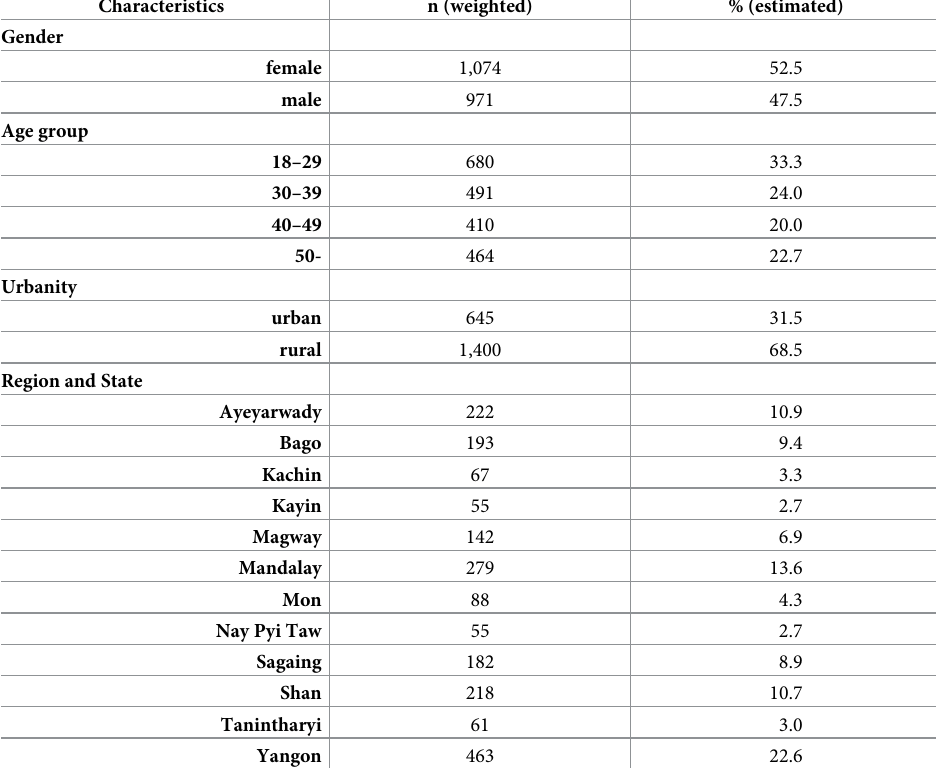
Table 1. Participants’ demographic characteristics in Myanmar, 2020 (N = 2,045).